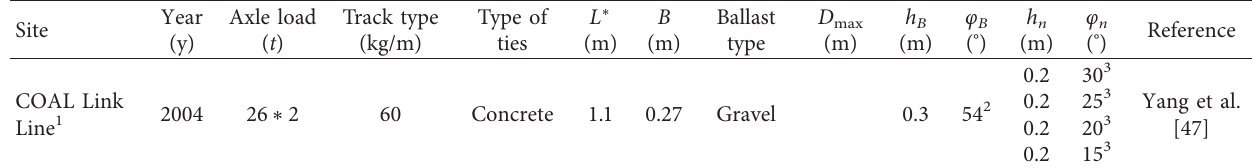
Table 3: Database of railway geometric parameters in South Africa.